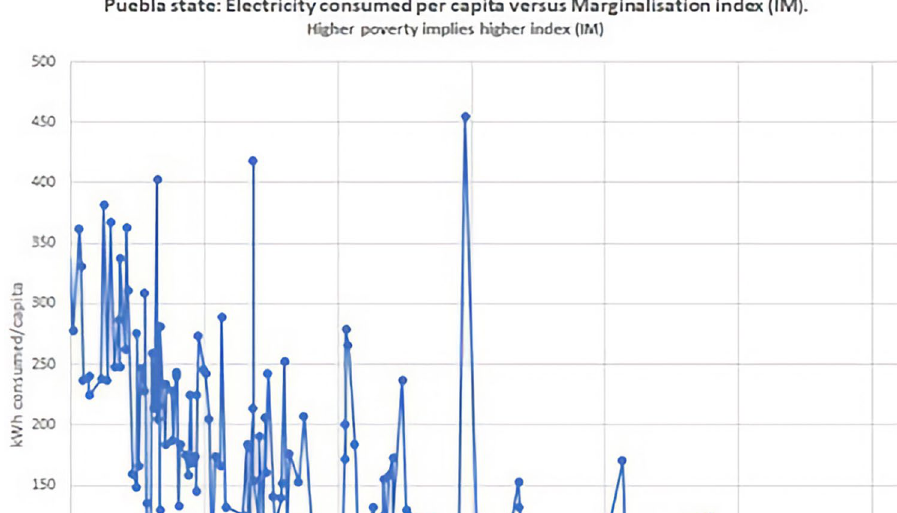
Fig. 16 Relation between Marginalisation Index (IM) and Electricity consumed per capita in Puebla